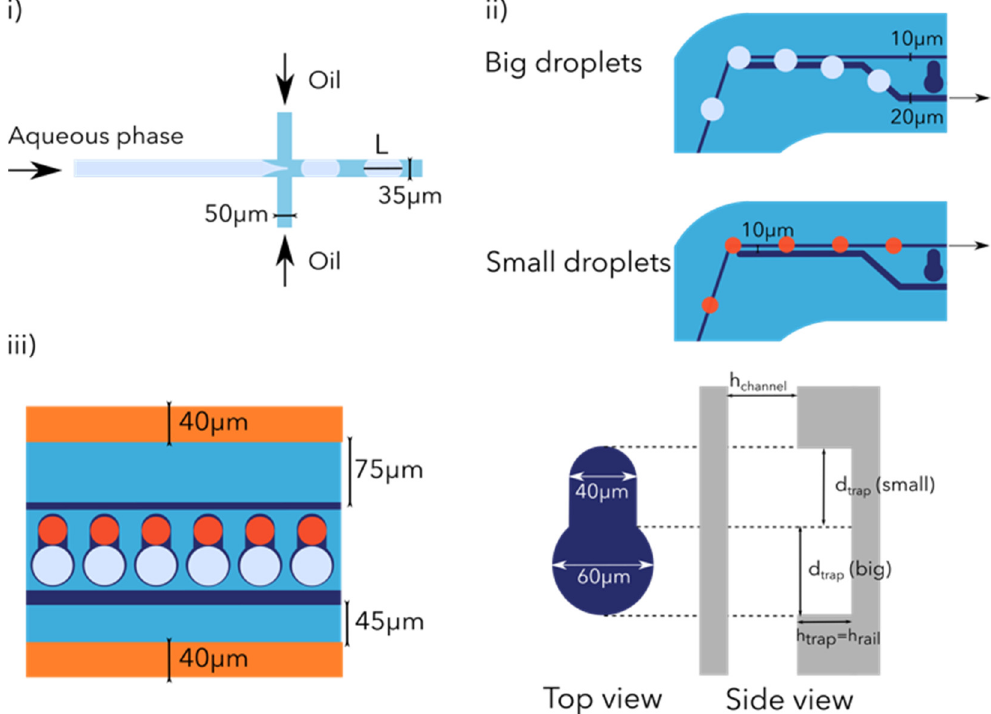
Figure 2. Schematic of some steps performed in the device. ( i ) Droplet generation. Scheme of the 2D 90° droplet generation system with the aqueous inlet and the oil inlets. The width of the microchannels is indicated and the droplet length in the confined configuration is indicated as L. ( ii ) Droplet railing. Scheme of the droplet size filtering system. Top: time lapse of a big droplet shifting from the original rail to the wider rail. Bottom: time lapse of a small droplet remaining on the original narrow rail. ( iii ) Droplet trapping and pairing. The left scheme shows the droplet trapping and pairing area with 5 traps filled with 2 droplets of each type. The electrodes used for droplet merging are represented (in orange). The right scheme shows top and side views of a single droplet trap; the critical trap dimensions for an efficient droplet trapping are indicated in the scheme. The trap height and the rail height are identical.